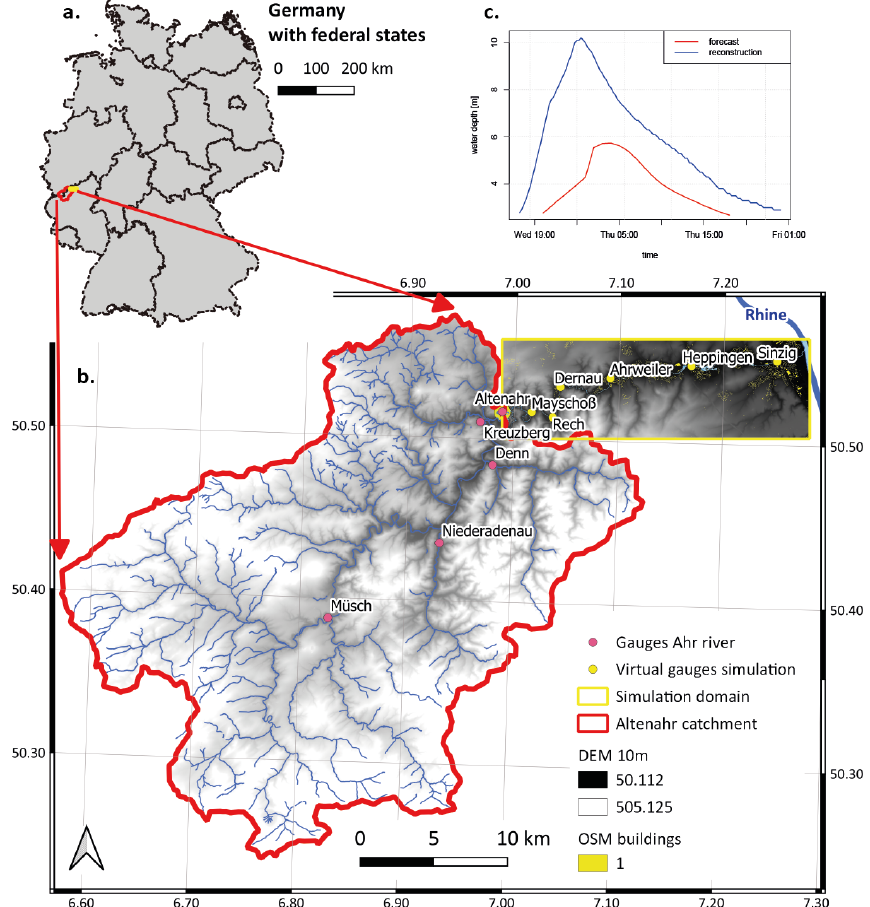
Figure 1. Overview of the Ahr catchment and the simulation domain (river reach Altenahr–Sinzig). (a) Location of the catchment draining to the Altenahr gauge and the simulation domain within Germany. (b) The catchment draining to the Altenahr gauge and the hydrodynamic simulation domain. (c) Boundary water depths used for simulating the flood event of 2021. “Forecast” indicates the forecasted water depth hydrograph issued by the Landesumweltamt Rheinland-Pfalz, and “reconstructed” indicates the preliminary (in January 2022) reconstructed water depth hydrograph at the Altenahr gauge of the event. The hydrographs start on 14 July and the time indicated at the time axis. Data sources: DEM 10m resolution: © GeoBasis-DE/BKG 2012 (https://www.bkg.bund.de/, last access: 30 January 2022); OSM river network and buildings: © OpenStreetMap contributors 2021. Distributed under the Open Data Commons Open Database License (ODbL)